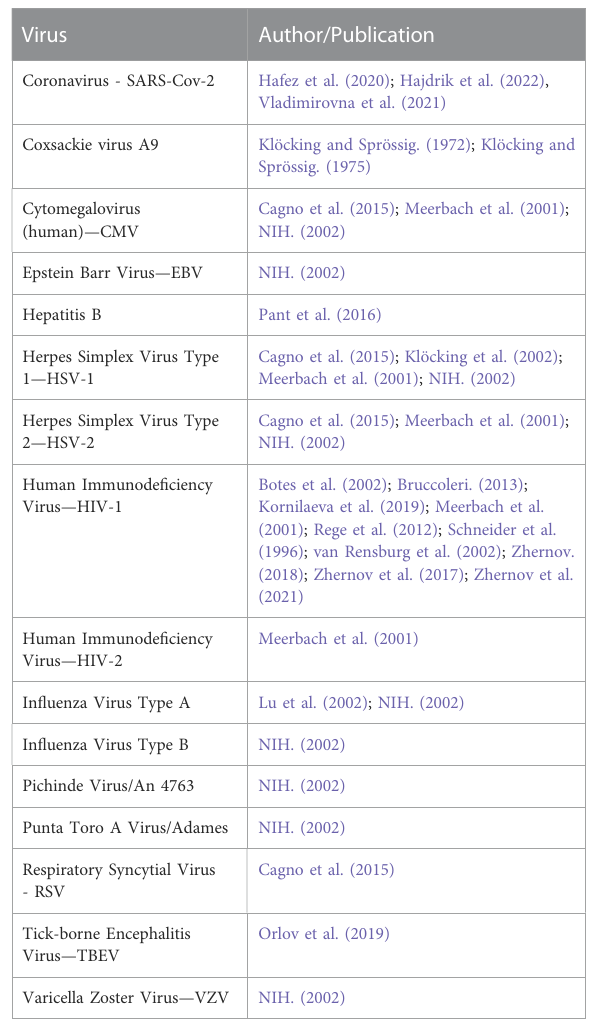
TABLE 1 The antiviral spectrum of humic